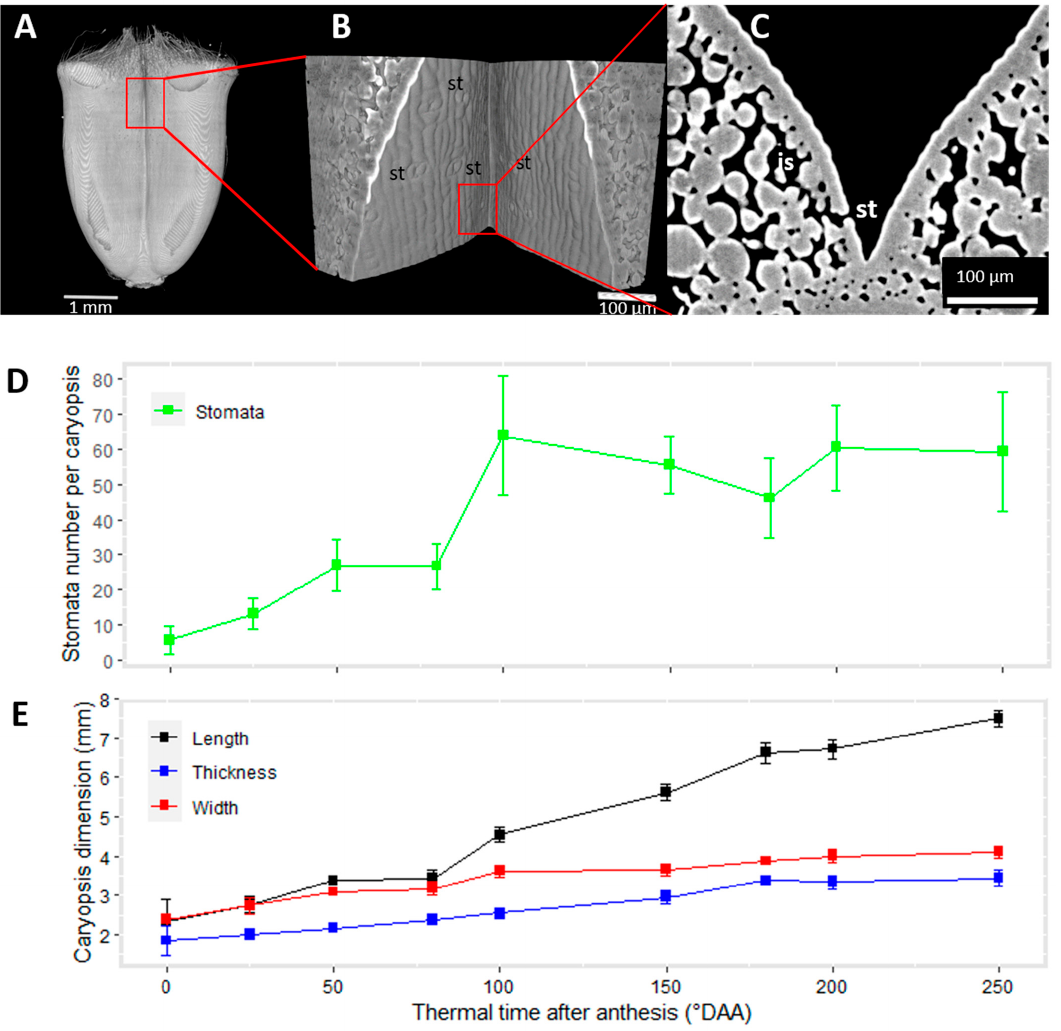
Figure 5. Stomata are present on the ventral face of wheat caryopses. A 2D projection of a 3D view of the caryopsis surface showing stomata in the ventral region of a caryopsis at 100 °DAA ( A ). Zoom on the epicarp of the caryopsis in the region depicted by the red frame ( B ). Virtual section across a stomata showing the guard cells and the substomatal chamber ( C ). Concomitant evolution along time of stomata number per caryopsis ( D ) and the whole caryopsis dimensions ( E ). Legend: st—stomata; is—intercellular